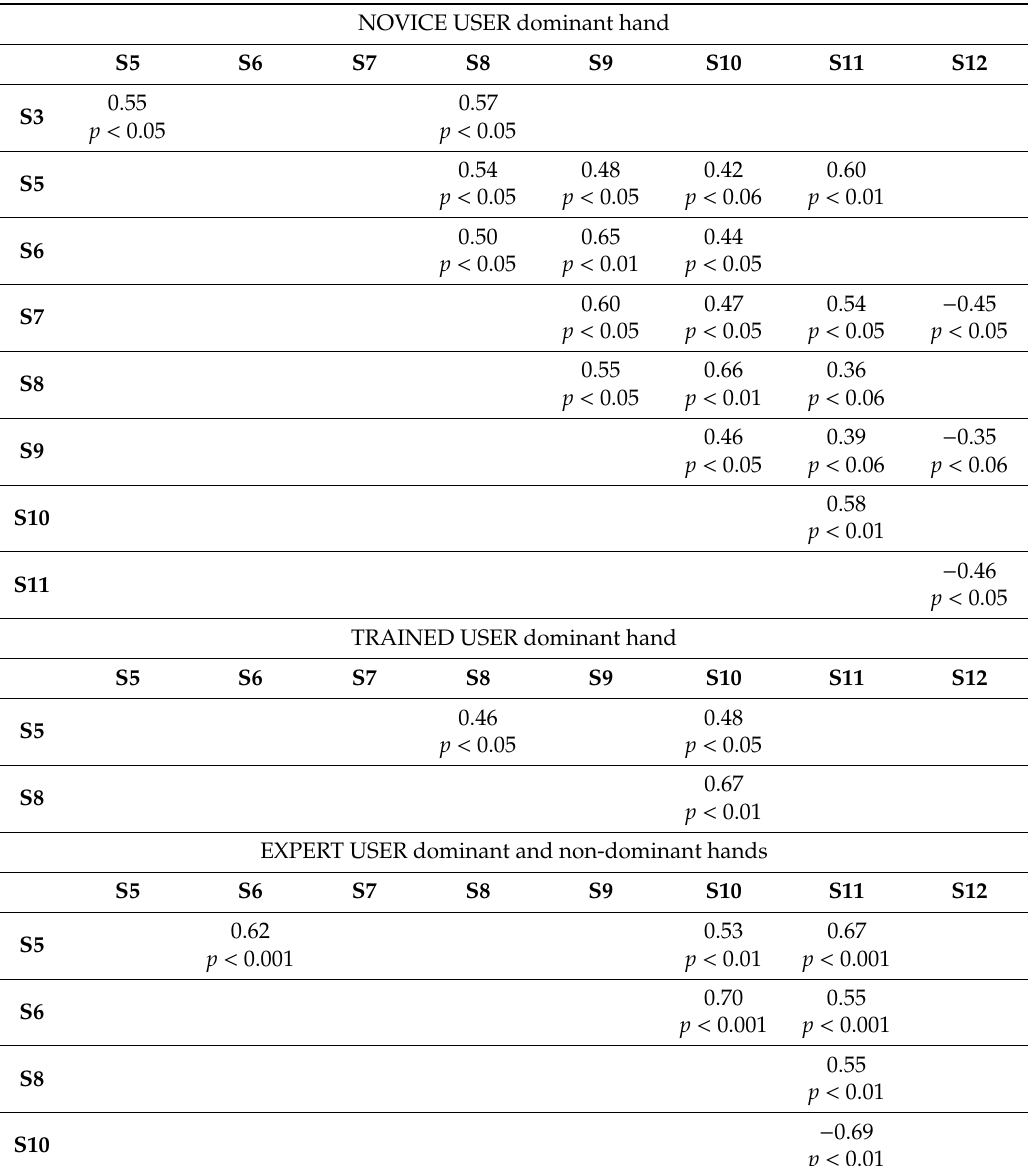
Table 3. Statistically significant correlations between sensor activities for each